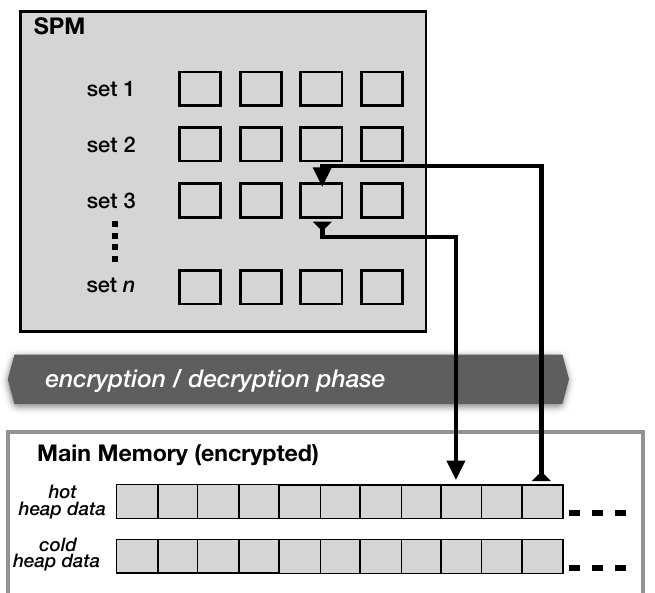
Figure 11. Heap management scheme with Enc/Dec